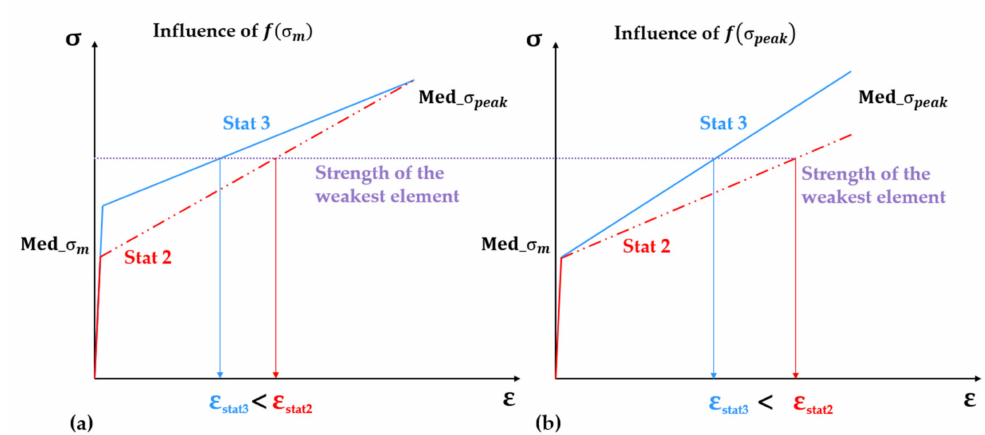
Figure 11. Effect of the shape of the probability distribution of ( a ) matrix strength and ( b ) tensile strength on the median values over all the finite-elements along the SHCC model specimens and, as a result, on the macroscopic strain at failure localization.